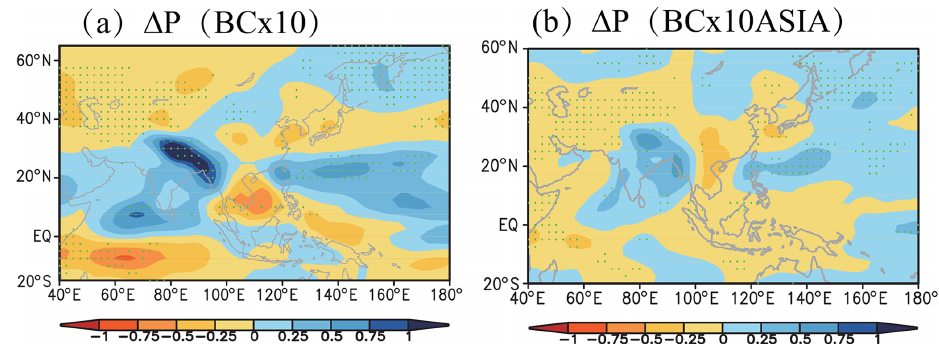
Figure 14. Changes in multimodel mean (MMM) of the MJJAS precipitation ( (cid:49)P ; unit: mmd − 1 ) under (a) increasing global (BC × 10) and (b) Asian BC (BC × 10ASIA). Dotted regions indicate where the MMM is more than 1 standard deviation away from